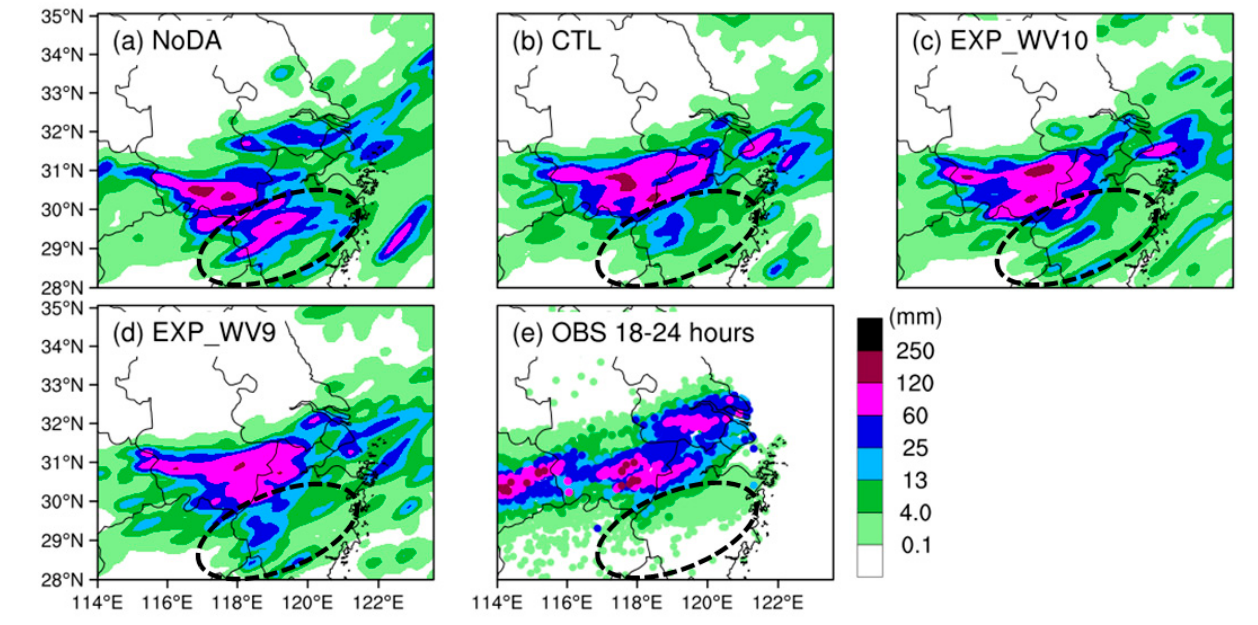
Figure 12. The 6 h accumulated precipitation distribution from 1800 UTC 5 July to 0000 UTC 6 July 2020, for the forecast fields of the ( a ) NoDA, ( b ) CTL, ( c ) EXP_WV10, ( d ) EXP_WV9 experiments, and ( e ) observed 6 h accumulated rainfall.